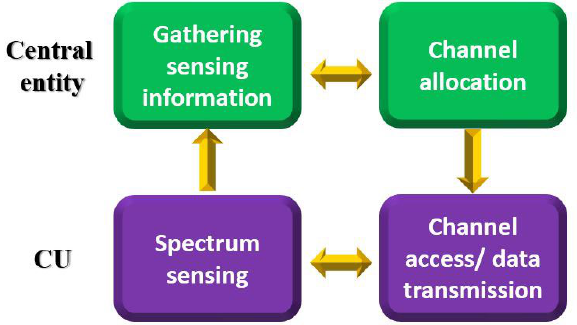
Figure 3. The channel sharing process of a UCAN.